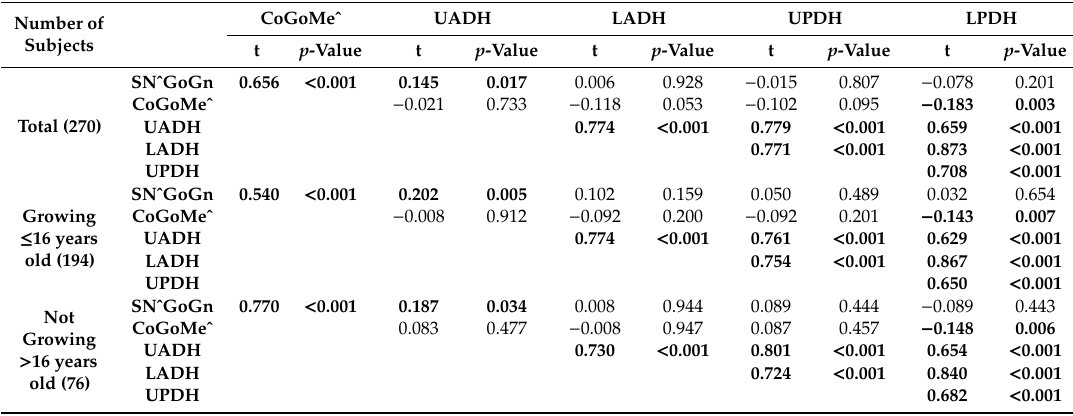
Table 3. Pearson correlation analysis.